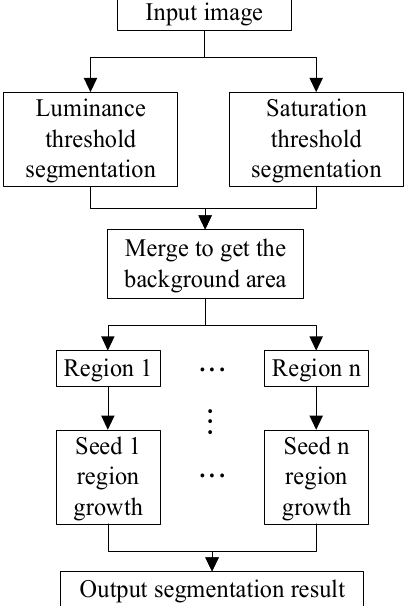
Figure 4. Flowchart of obstacle segmentation.